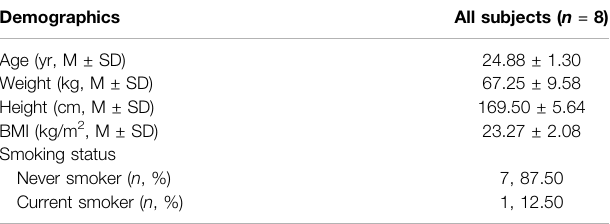
TABLE 1 | Demographic characteristics of research subjects. Demographics